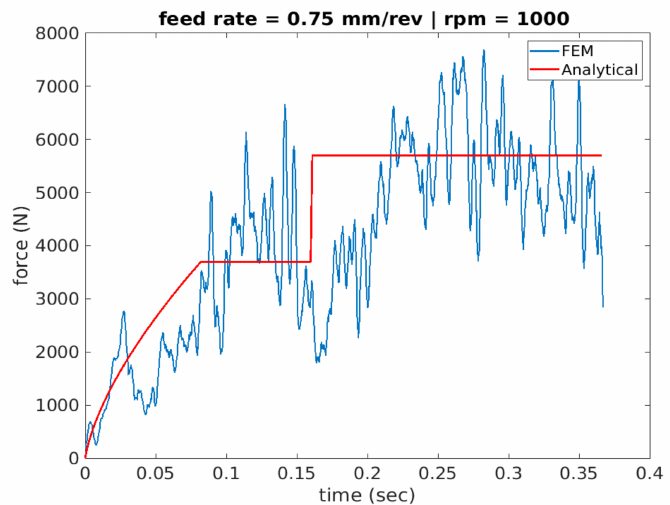
Figure 11. Thrust force profile for scenario 1 of feed rate 0.75 mm/rev and 1000 spindle rpm (analytical vs.